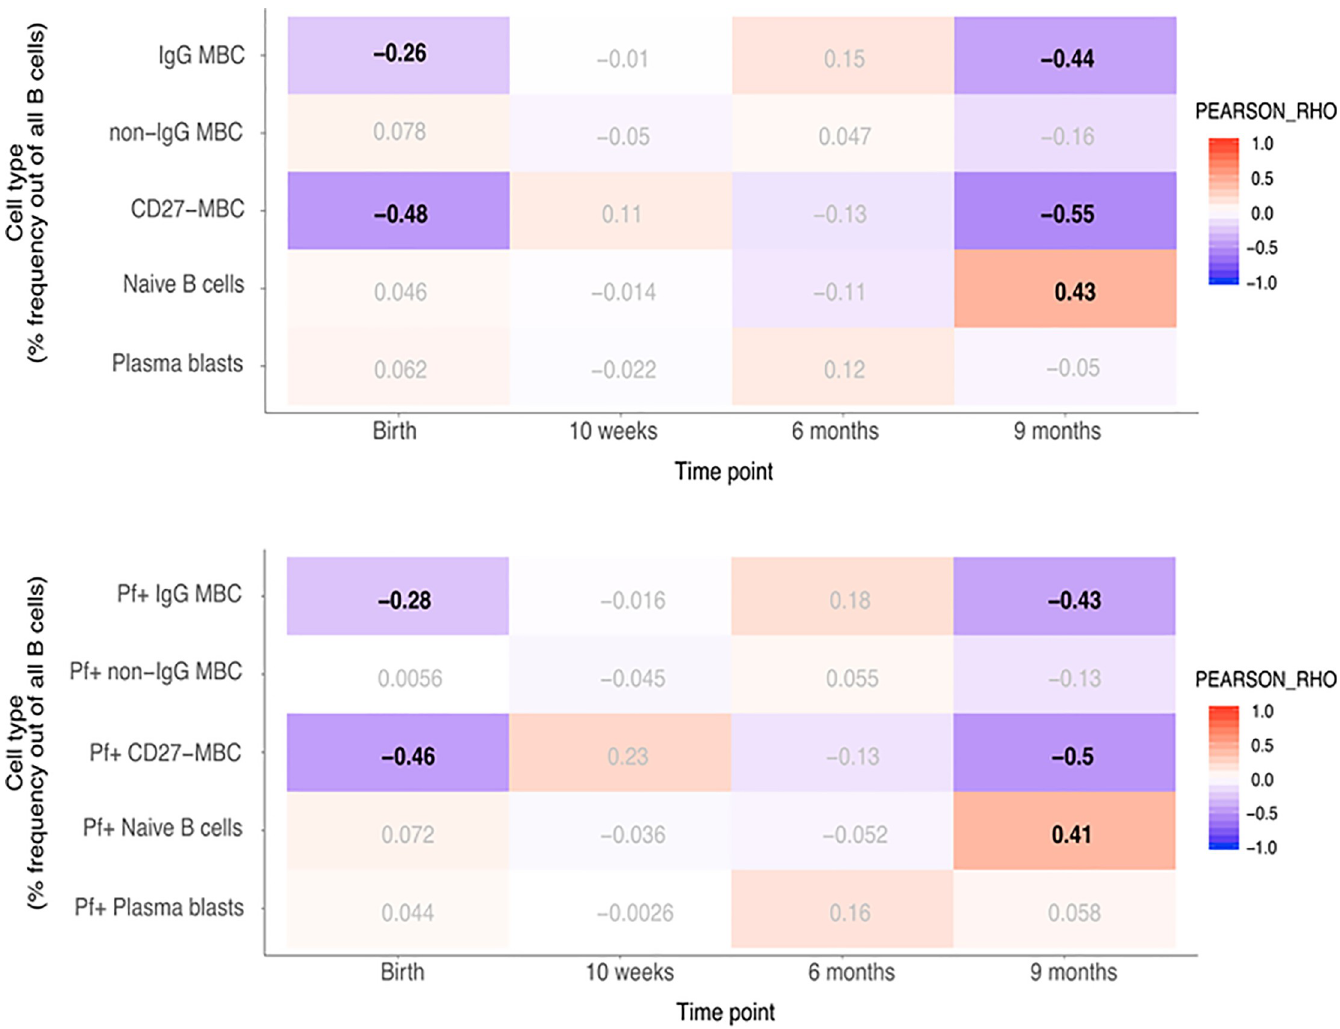
Fig 2. Correlation heatmap of BAFF concentration and given subsets of B cells in infants. A. Pearson correlation with adjusted p-value for multiple testing using the Benjamini-Hochberg method. Pearson’ rho values with a false discovery rate (FDR) < 0.05 in bold. B. Correlation heatmap of BAFF concentration and Pf+ proportions of given subsets of B cells in infants. Pearson correlation with adjusted p-value for multiple testing using the Benjamini-Hochberg method. Pearson’ rho values with a false discovery rate (FDR) < 0.05 in